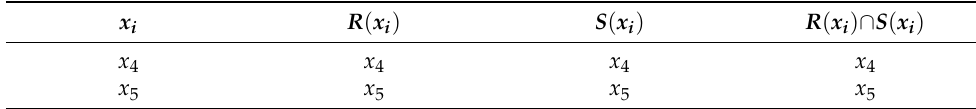
Energies 2022 , 15 , 9502